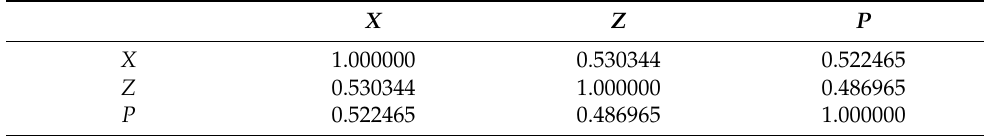
Table 2. Sample correlation coefficient matrix.